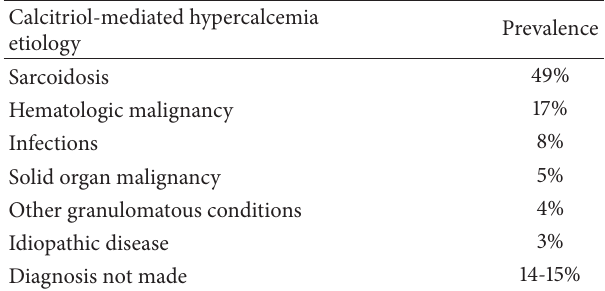
Table 3: Calcitriol-mediated causes of hypercalcemia and their prevalence. Information gathered from a review of 101 proven calcitriol-mediated hypercalcemia cases